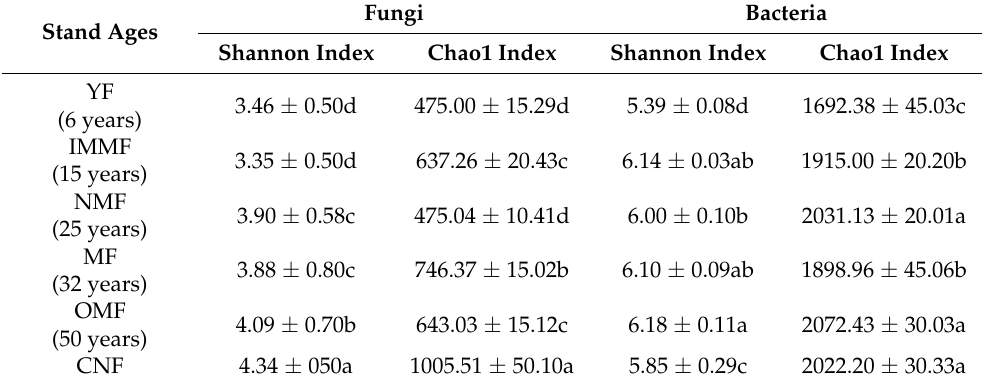
Table 4. Diversity indices calculated from gene sequence date at the OTU level. Different lowercase letters between different stand ages indicated significant differences as determined by Tukey’s HSD test ( α = 0.05).